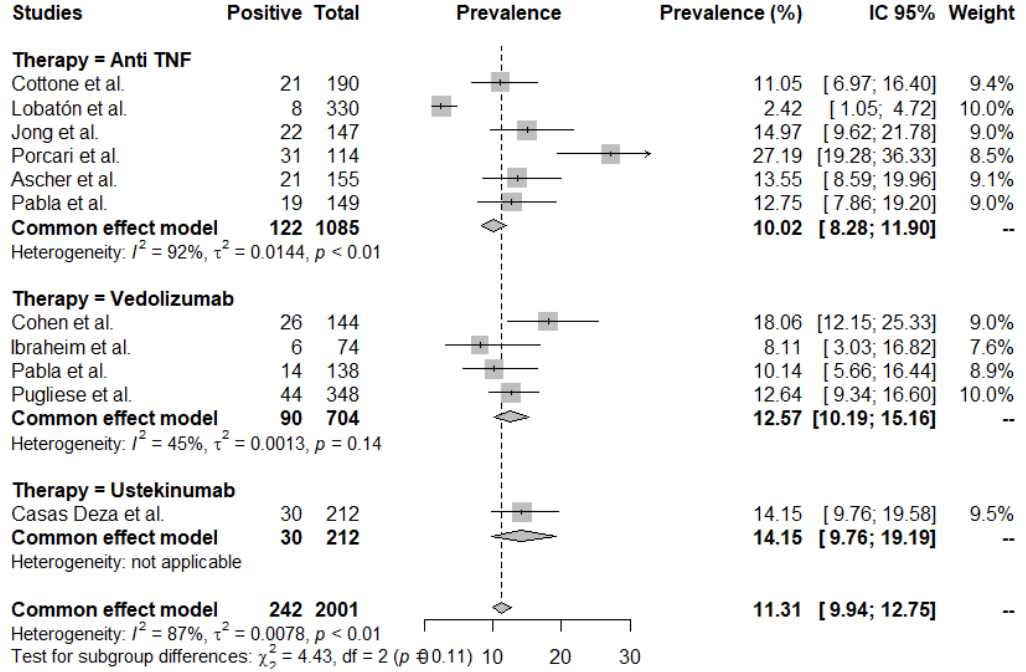
Figure 2. Rates of adverse events (AE). Mean rates per 100 patient years (PY).